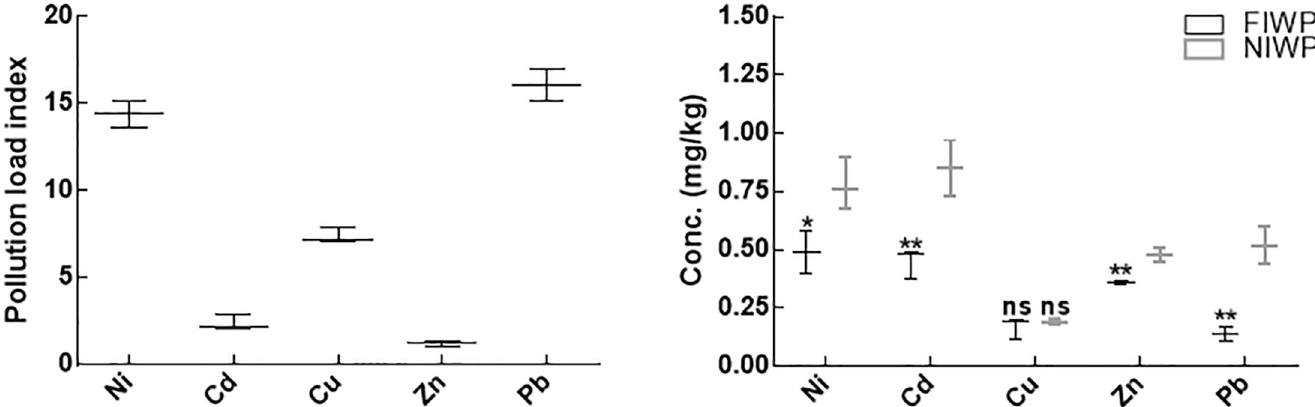
Fig 9. Pollution load index and pollutant concentration factor. Fig 9A represents pollution load index values of heavy metals in contaminated and reference soil; Fig 9B represents pollutant concentration factor values of heavy metals in fungal inoculated non-inoculated wheat plants in contaminated soil; FIWP = fungal inoculated wheat plant; NIWP = non-inoculated wheat plant; Ni = nickel; Cd = cadmium; Cu = copper; Zn = zinc; Pb = lead. The experiment was carried out in triplicate, each replicate comprised of 10 pots and each pot contained 6 seedlings (total = 6 × 10 × 3 = 180 seedlings per treatment). Means of fungal inoculated wheat plants (FIWP) were compared with non-inoculated wheat plants (NIWP) by using ttest; The experiment was carried out in triplicate, each replicate comprised of 10 pots and each pot contained 6 seedlings (total = 6 × 10 × 3 = 180 seedlings per treatment); ‘ �� ’ represents significant difference at P = 0.005; ‘ � ’ represents significant difference at P = 0.05; ‘ns’ represents non-significant difference at P =